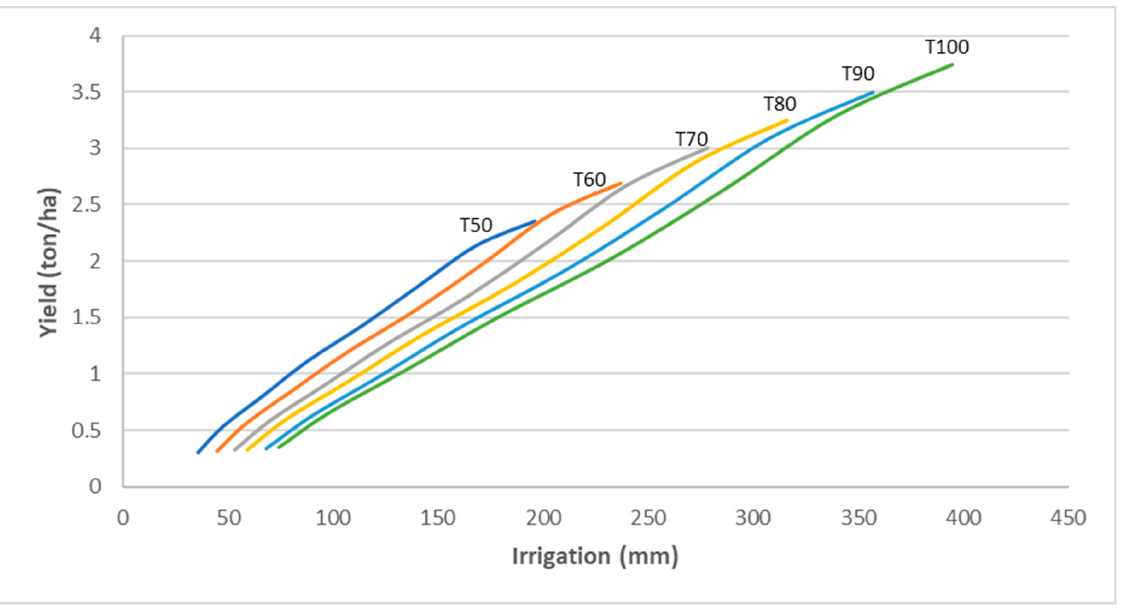
Figure 5. The crop production yield versus the irrigation level for the barley crop.